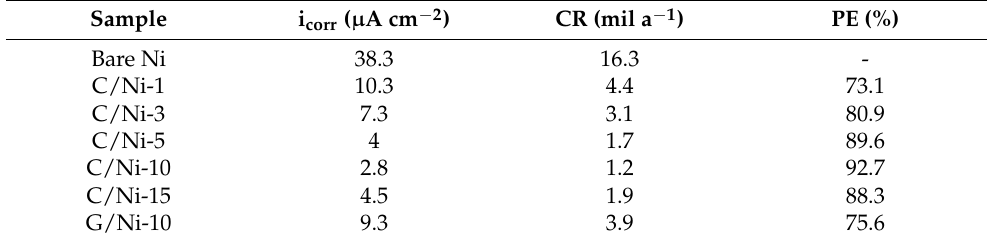
Figure 5. ( a , b ) Polarization curves of bare Ni and coated Ni samples, ( c ) the dependence of the corrosion rate of the samples on the coating type. Table 1. The i corr , CR and PE of the samples.